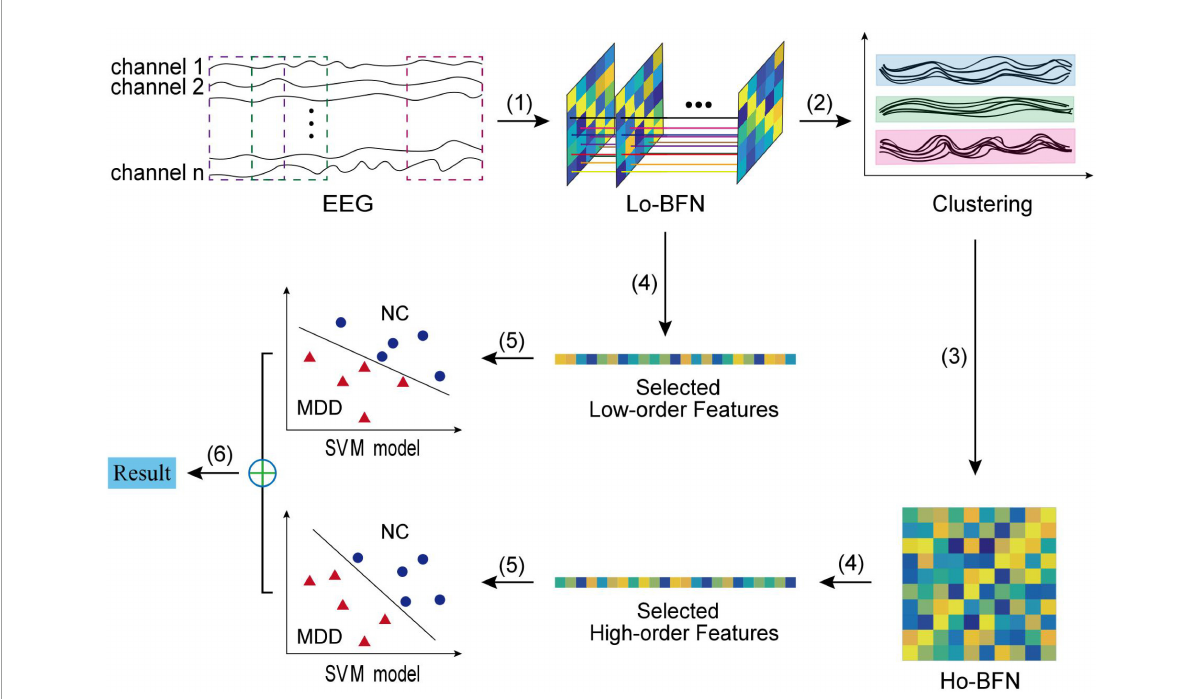
FIGURE2 The flowchart of the proposed BFN classification framework, including six main steps: (1) constructing LO-BFN; (2) clustering the time series; (3) constructing HO-BFN; (4) feature selection; (5) constructing SVM model; and (6) classification fusion.